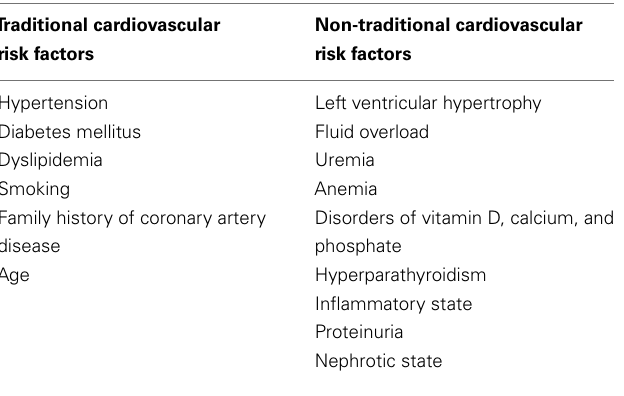
Table 1 | Cardiovascular risk factors in the chronic kidney disease population .